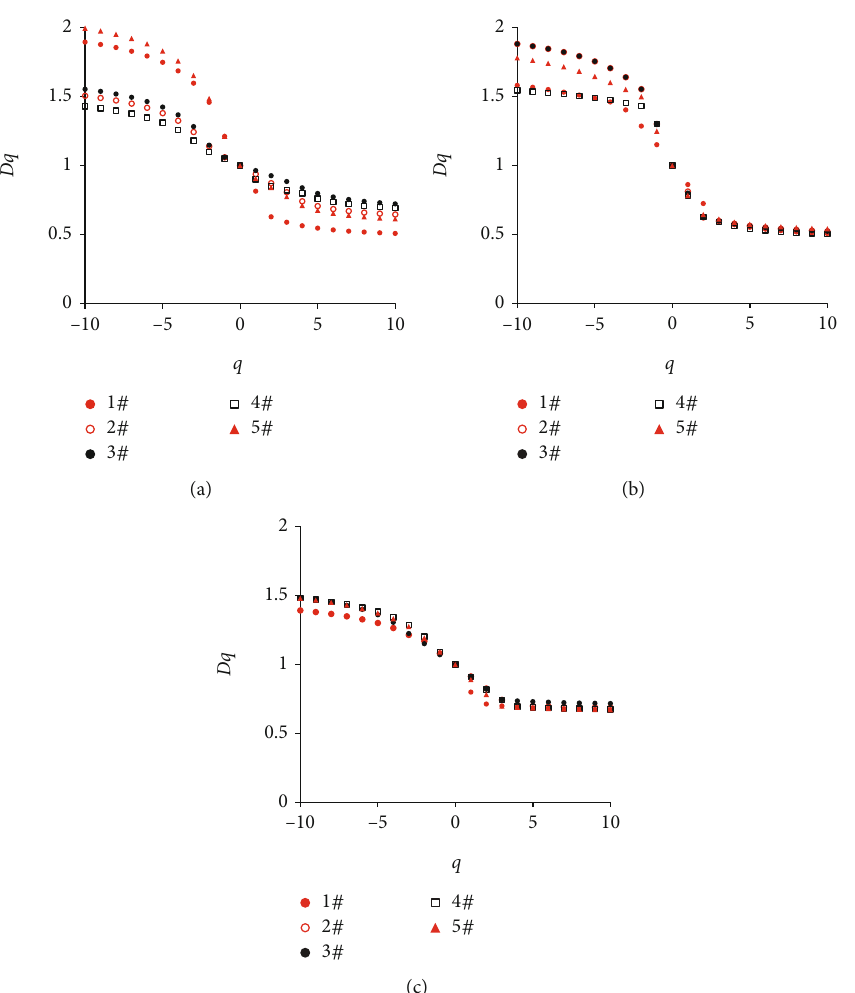
0.00.51.01.52.0